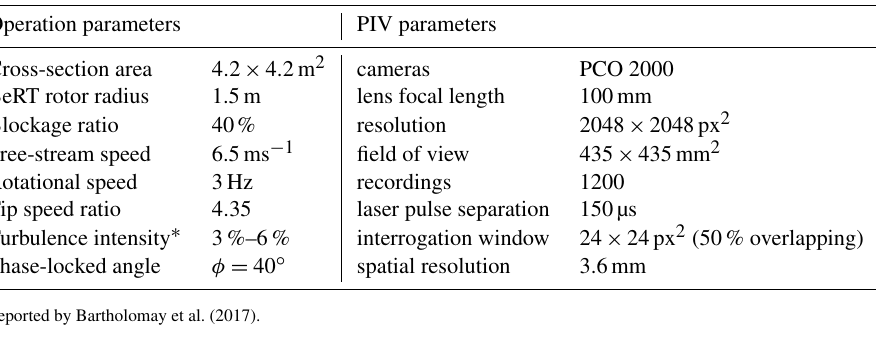
Table 3. Operation and image acquisition details.